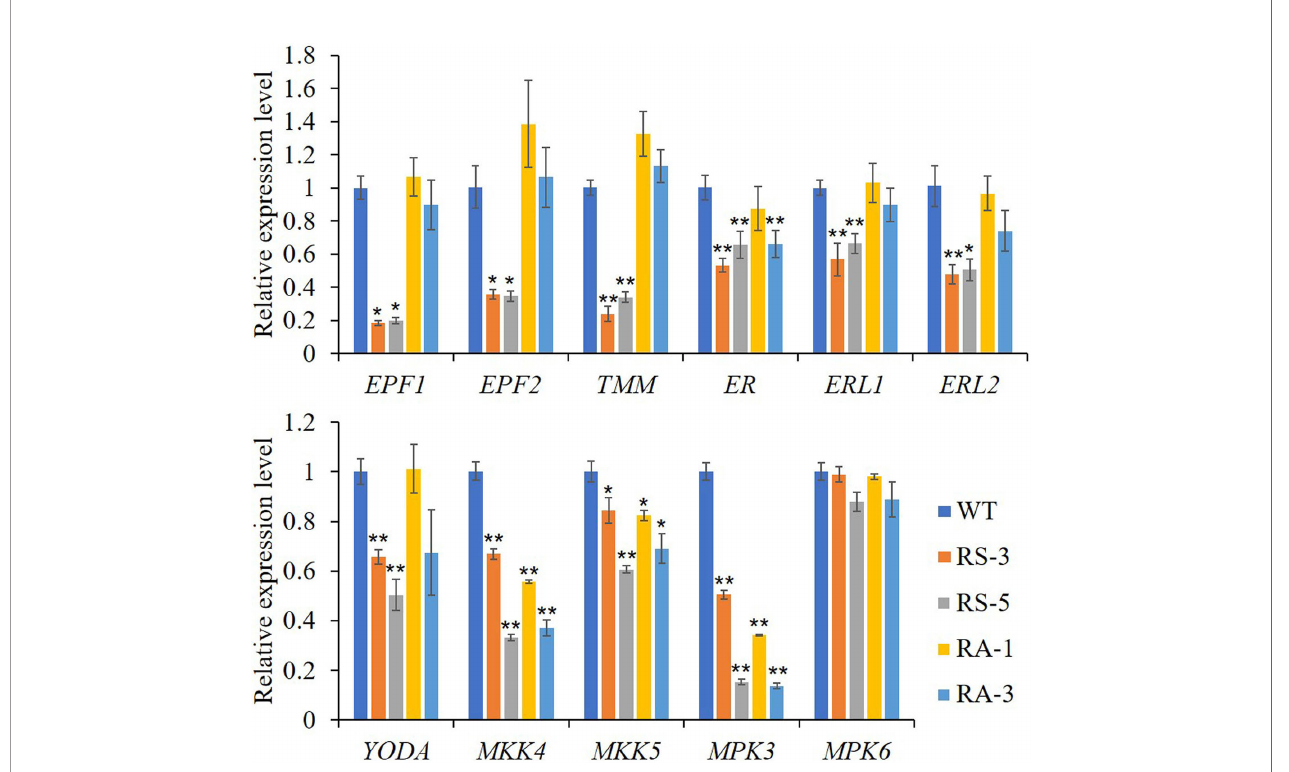
FIGURE 6 | qRT-PCR analysis of genes related to ER signaling pathway. WT, wild type; RS-3 and RS-5, ZmRLK7 sense transgenic lines; RA-1 and RA-3, ZmRLK7 antisense transgenic lines. AtUBQ10 mRNA level was used as internal control. Values are means of three biological replicates with SD. * and ** denote signi fi cant differences at p < 0.05 and 0.01 by ANOVA, respectively. All comparisons were with the WT as the